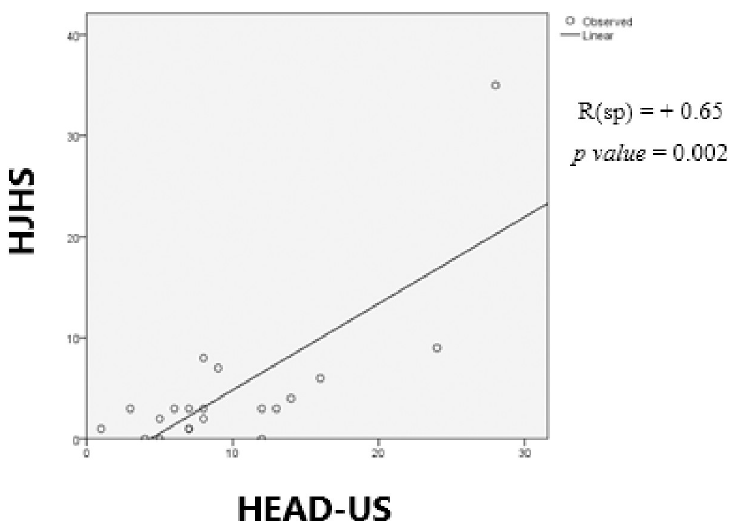
Fig 2. Correlation between HEAD-US and